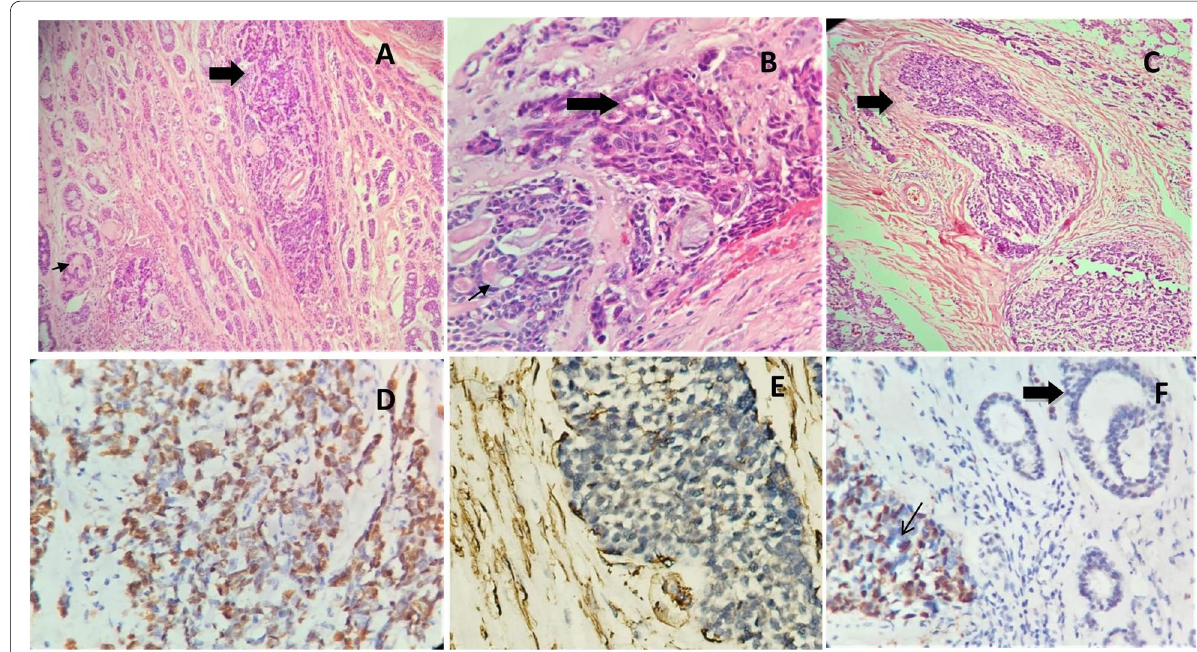
Fig. 3 Histopathological examination and immunohistochemistry studies of the tumor. The tubular and cribiform pattern of conventional ACC (thin arrow) with a transition to a solid high grade carcinoma (thick arrow) A ) H&E x100, B ) H&E x400. C ) Tumour infiltrating a nerve (thick arrow) H&E x100. Ki67 labelling index was D ) 70% in High grade component. Smooth muscle actin (SMA) showed E ) Loss of expression in high grade (thick arrow)